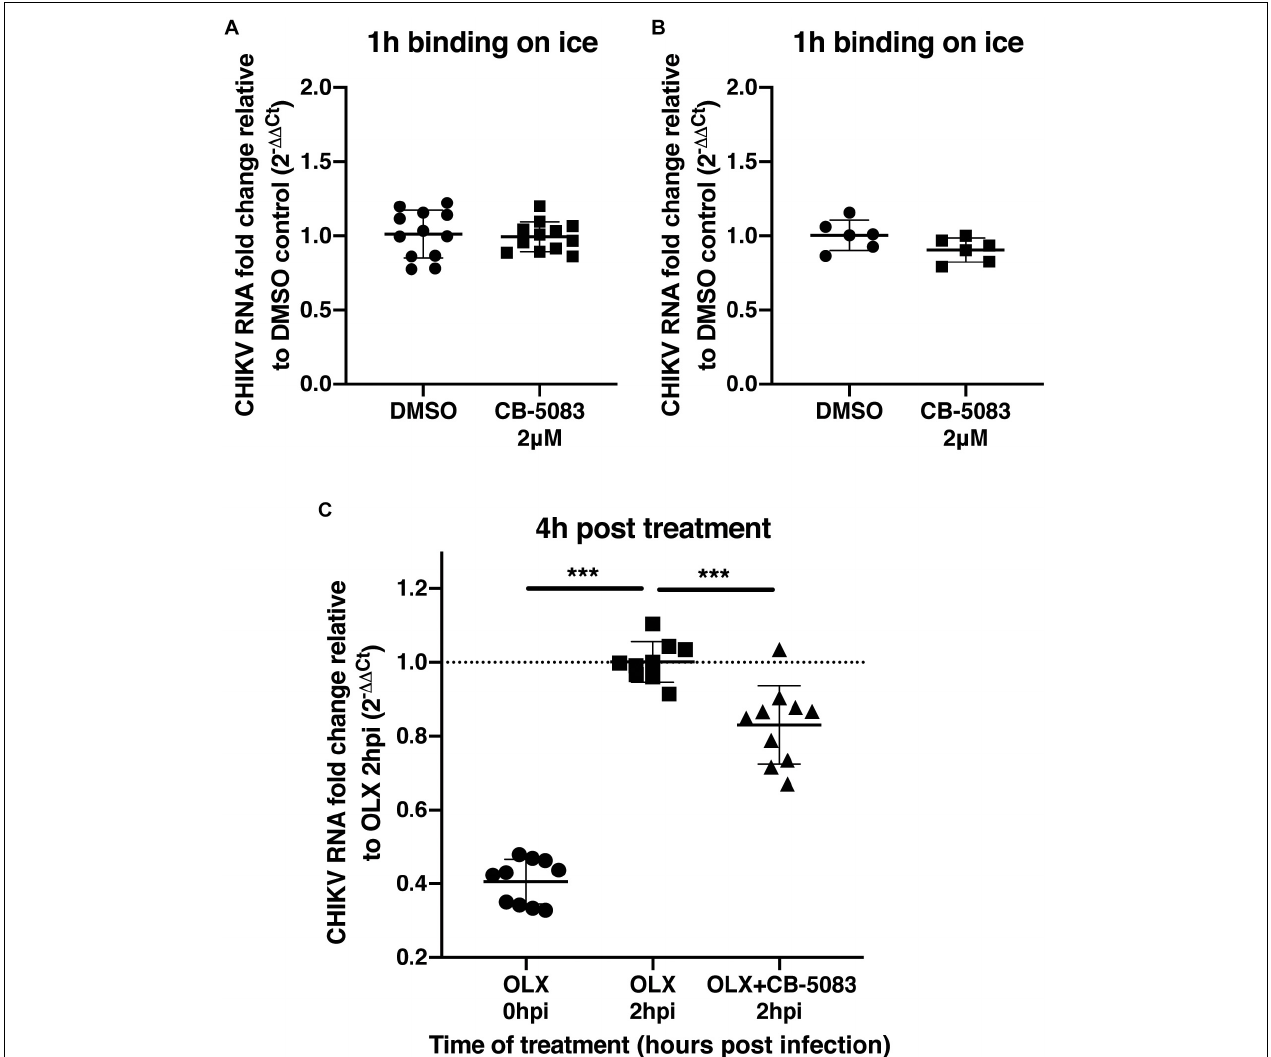
FIGURE 3 | VCP is not involved in CHIKV binding or entry. (A,B) Two hundred thousand HEK 293T cells per well were infected at moi 10 for 1 h in DMEM media or in media with 2 µ M CB-5083 on ice or at 37 ◦ C, respectively. Cells were then washed twice in PBS, collected, and RNA was extracted. (C) Two hundred thousand HEK293T cells per well were infected at moi 10 for 2 h in DMEM media or in media with 0.5 µ M OLX. After 2 h, inoculum was removed, cells were washed twice and incubated for 4 h in media with CB-5083 at 2 µ M or media with OLX (0.5 µ M) and CB-5083 (2 µ M) or media with OLX (0.5 µ M), the cells were then washed twice, collected, and RNA was extracted. Relative CHIKV RNA fold change compared to control using 2 − (cid:49)(cid:49) C T method. Each symbol represents an independent well, data presented are from three independent experiments for panels A and C and two independent experiments for panel B represented as mean ± SD and were analyzed by Mann–Whitney non-parametric two-tailed test for panel D ; ∗∗∗ p <